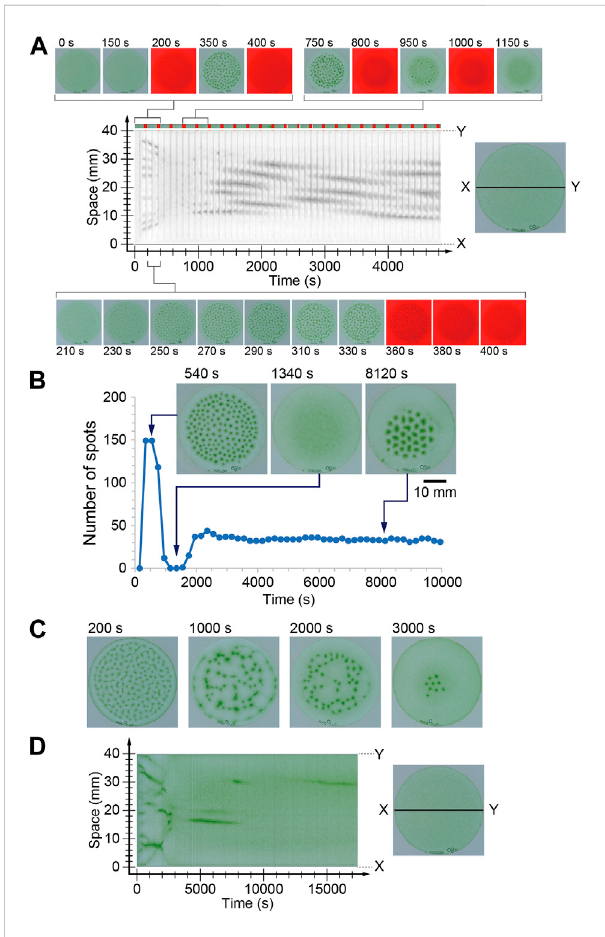
FIGURE 2 (A, B) Time series of the number of spots under the periodical illumination (200 s in the period). The space-time diagram in (A) was indicated gray scale image ofred color. The dark periods areindicated in red on the color bar at the top of space-time diagram. (C, D) Time evolution of the bioconvection pattern under periodical changing light intensity whose period was 20